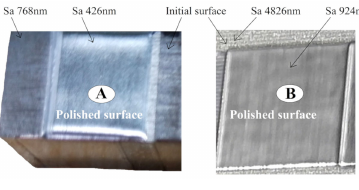
Figure 4. Polished